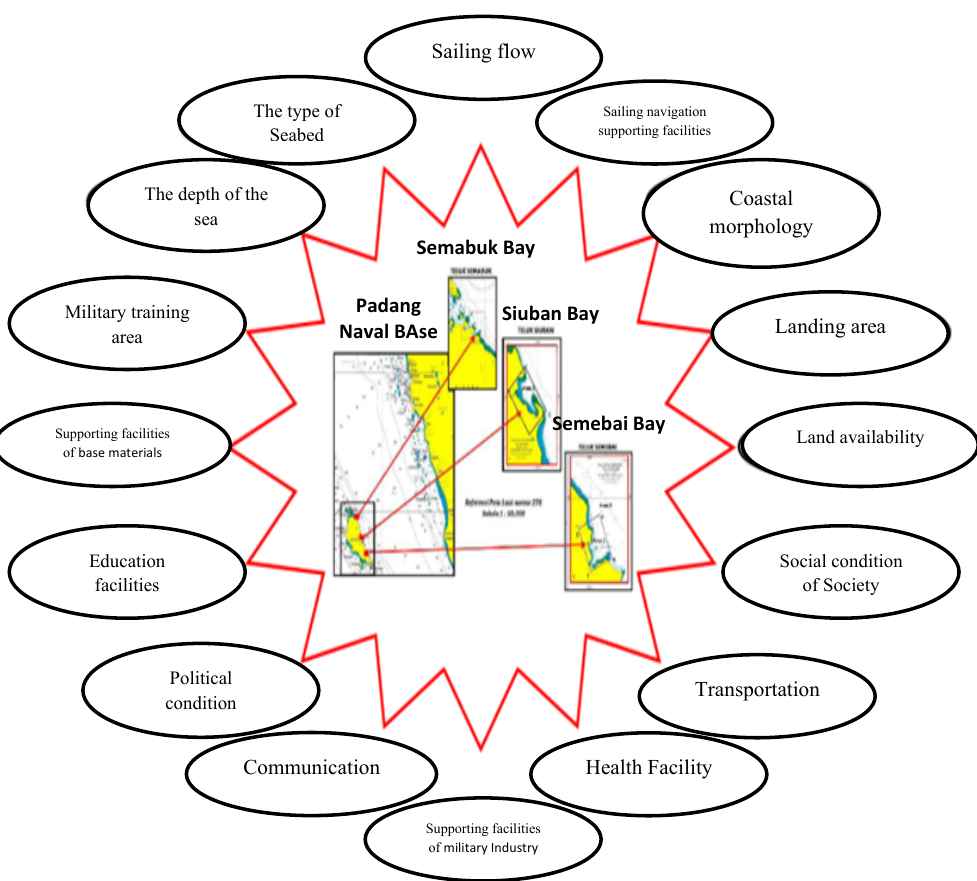
Fig. 2. Model Selection Criteria Location of Naval Base